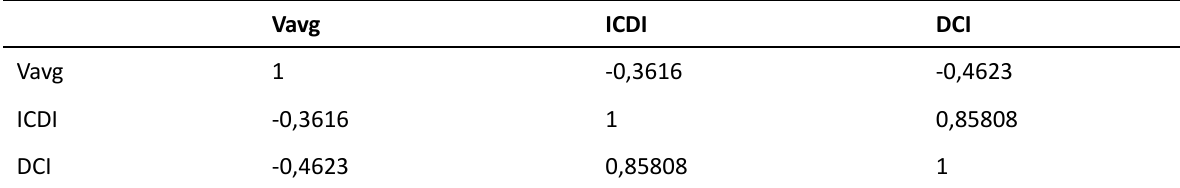
Table 2. Correlation analysis of the integral characteristics of the swim cycle of crawl-stroke swimmers